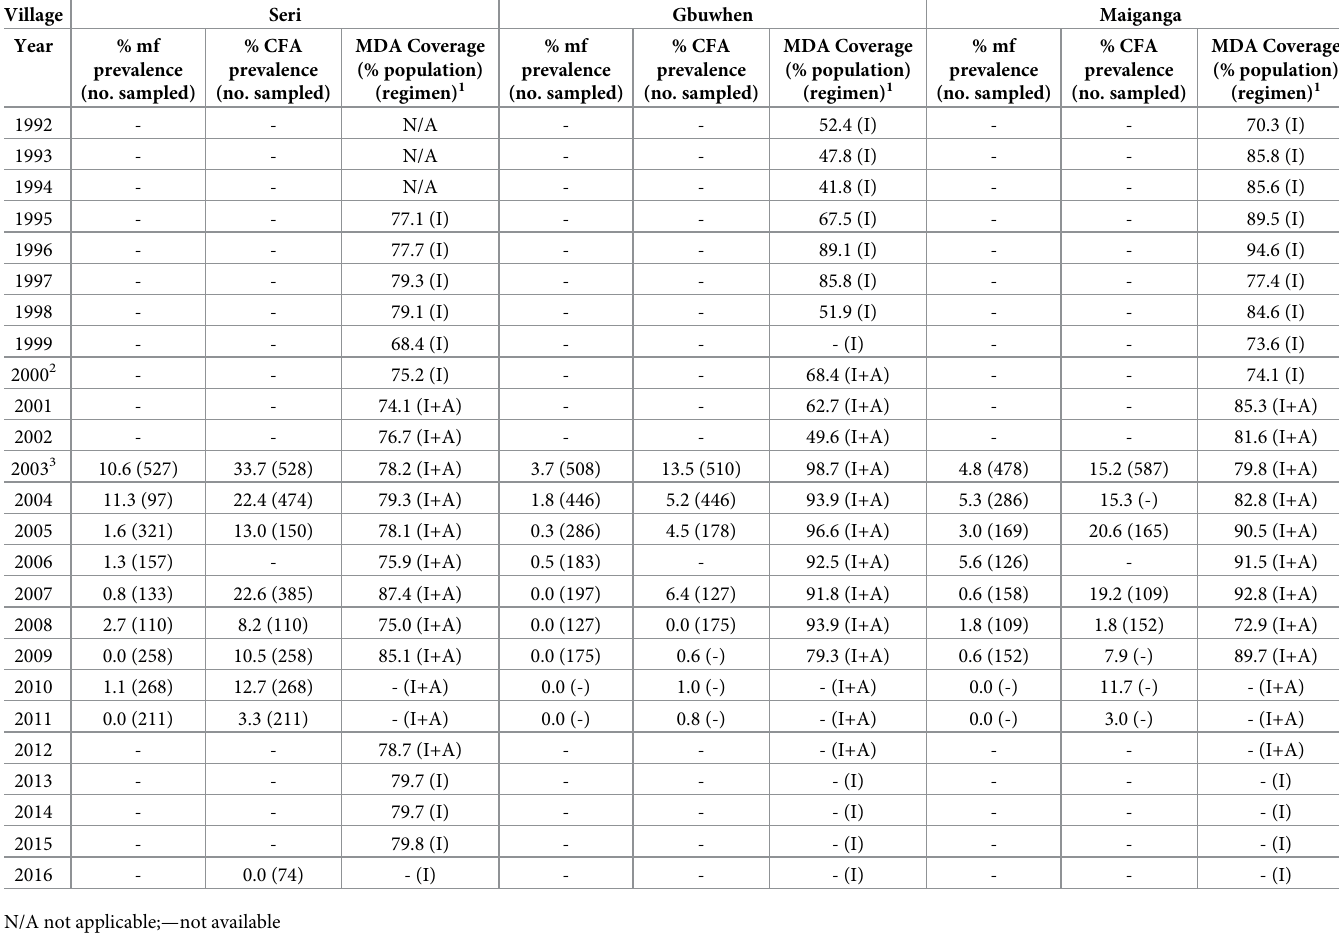
Table 1. Monitoring epidemiological survey data and intervention details for Seri, Gbuwhen, and Maiganga, Nigeria.